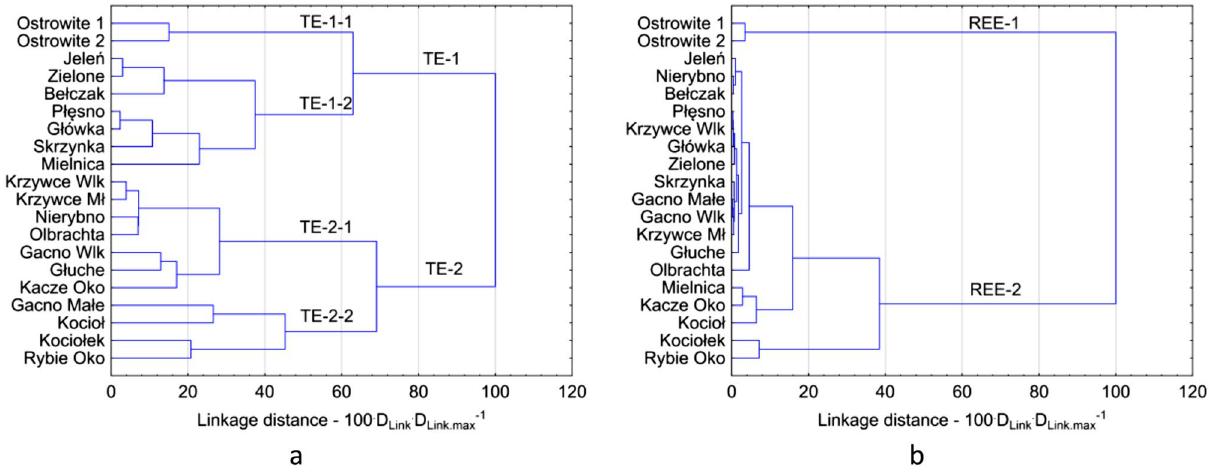
Figure 6. CA analysis results for TEs ( a ) and REEs ( b ). Figure generated in Statistica 13. (https ://softw are.dell. com/produ cts/stati stica